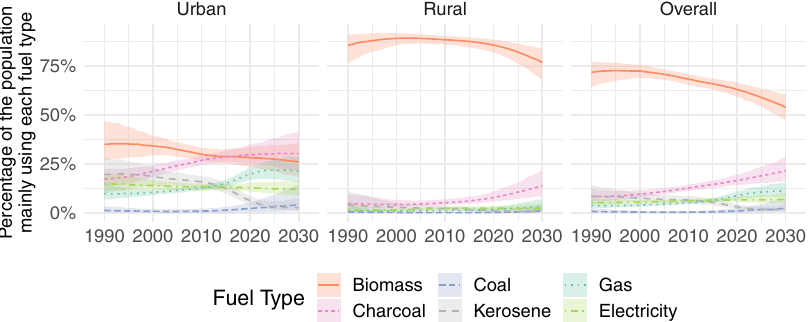
Fig. 7 Cooking fuel use in Sub-Saharan Africa. Estimated (posterior median) percentage of the population in Sub-Saharan Africa mainly using each fuel type (lines), with 95% uncertainty intervals (shaded areas). Plots for other regions are included in the Supplementary